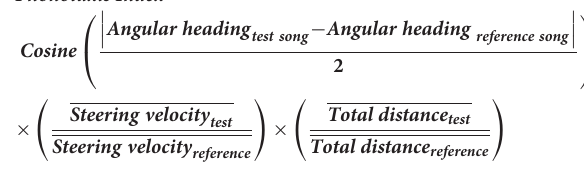
preferred pulse rates (10–40 and 60–100 pps, all Ps <